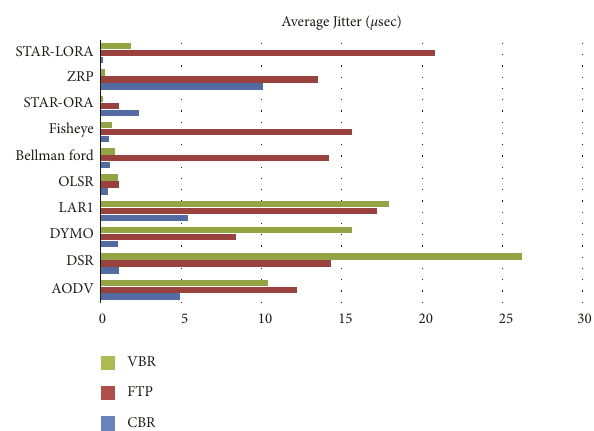
Figure 32: Average transmission delay of all routing protocols in CBR, FTP, and VBR applications.